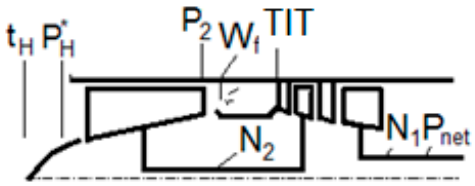
Figure 2. Scheme and measured parameters of the engine.